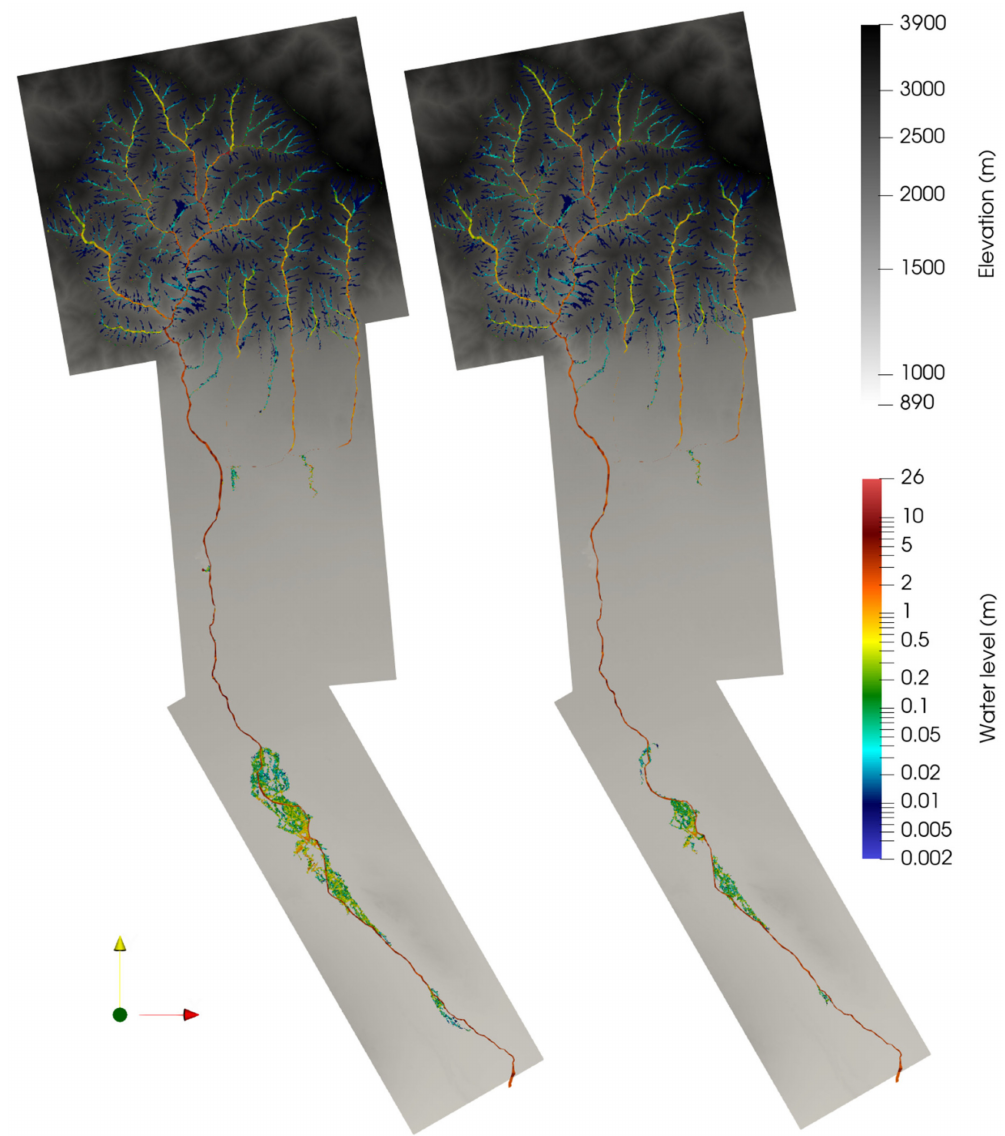
Figure 10. Spatial distribution of the maximum water depths for the σ 2 = 99.2 rainfall (Figure 3e) under the stationary rainfall ( left ) and a moving rainfall with v = 5 km/h with a direction from west to east ( right